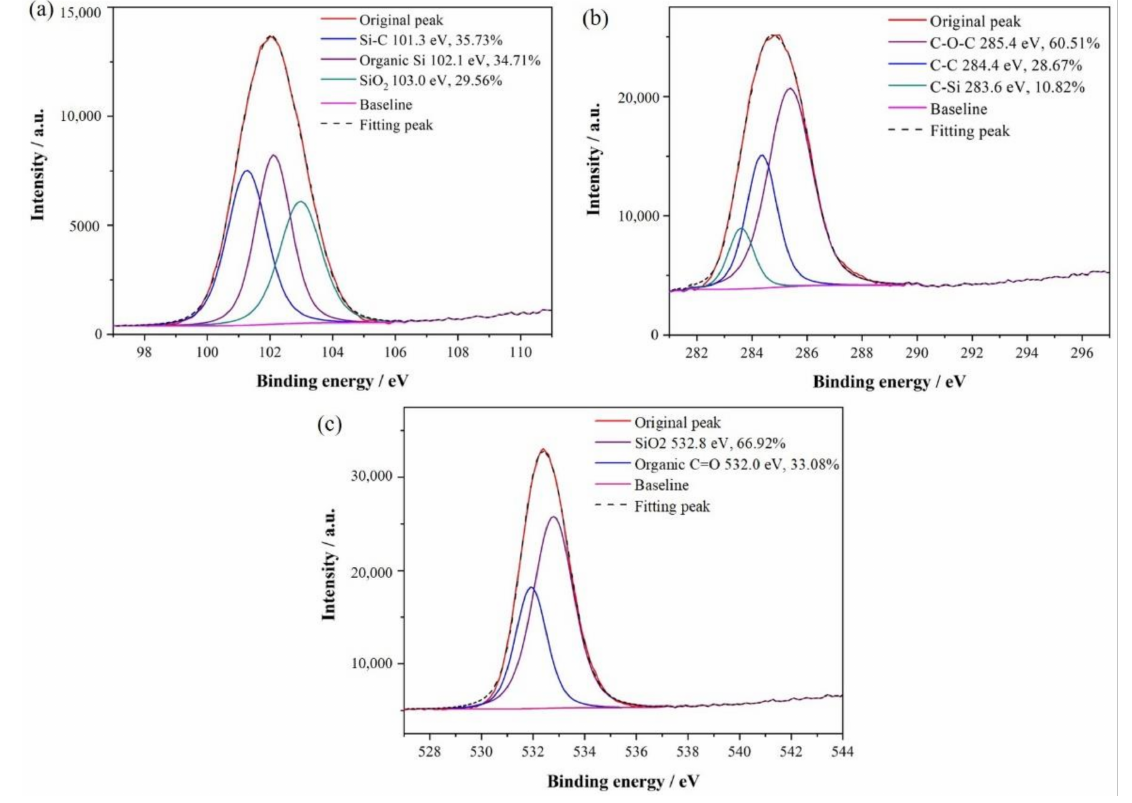
Figure 3. The narrow scan of the XPS of the SiC nanoarrays after vacuum heat-treatment: ( a ) Si 2p ; ( b ) C 1s ; ( c ) O 1s